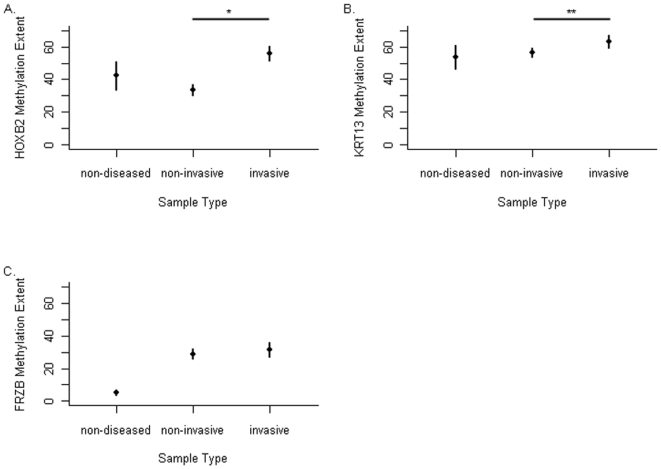
Bisulfite pyrosequencing reveals a greater extent of methylation in invasive bladder cancer.The mean (filled circle) and 95% confidence intervals of the extent of methylation of the promoter regions of (A) FRZB, (B) KRT13, and (C) HOXB2 are depicted (y-axis) comparing non-diseased bladder epithelium, non-invasive tumors and invasive tumors (x-axis). The differences in the extent of methylation across these groups is significantly different (Kruskal-Wallis test), for HOXB2 (P<0.00001) and KRT13 (P<0.04), and FRZB (P<0.003). Comparisons specifically of noninvasive compared to invasive disease also revealed significant differences for HOXB2 *P<0.00001 and KRT13 **P<0.02.